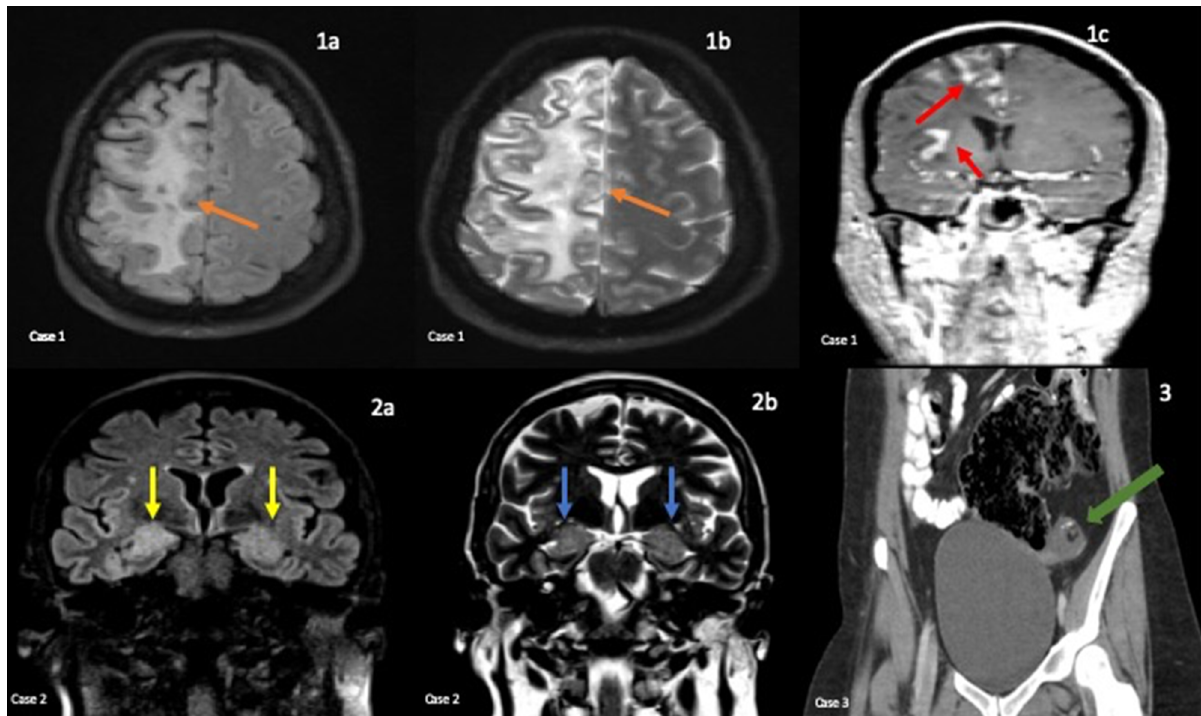
Figure 1. CASE 1: Axial FLAIR ( 1a ), Coronal T2 ( 1b ), and post contrast coronal T1 RAGE ( 1c ) sequences. Multifocal areas of confluent subcortical T2/FLAIR hyperintensity (orange) with overlying gyriform cortical enhancement (red) involving the right frontal, parietal, and occipital lobes. CASE 2: Coronal FLAIR ( 2a ) and T2 ( 2b ) sequences. Symmetric T2 (blue) and FLAIR (yellow) hyperintensity with mild swelling in the mesial temporal lobes involving the amygdala and hippocampi. CASE 3: Coronal CT of the pelvis with IV and oral contrast ( 3 ). Left ovarian mass containing fat and calcification consistent with a teratoma (green).